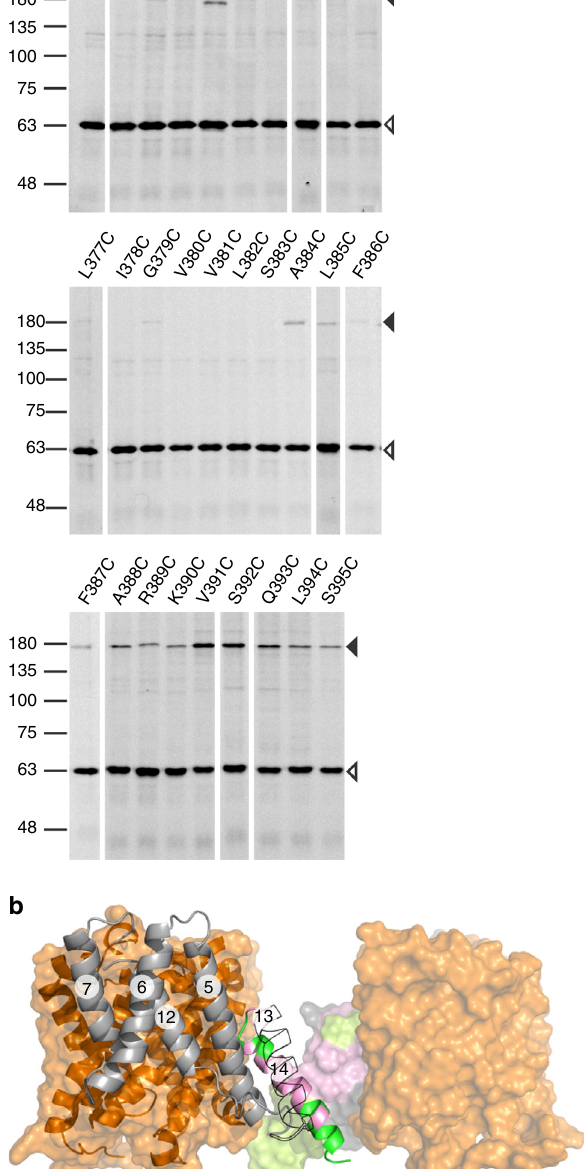
Fig. 4 Oxidative cysteine cross-linking between TM14 of SLC26Dg. a In gel GFP fl uorescence analysis of disrupted E. coli cells expressing single- cysteine variants of SLC26Dg fused to superfolder GFP. Following oxidative cross-linking, samples were analyzed by non-reducing SDS- PAGE. Cysteine-free SLC26Dg (cysless) and L144C (TM5) represent negative controls. Black and white arrows indicate dimeric and monomeric SLC26Dg. Source data are provided as a Source Data fi le. b Side view of the SLC26Dg dimer model. Core and gate domain are colored orange and gray, respectively. Positions in TM14 susceptible to cross-linking are colored in green, non-susceptible residues are colored pink. The gate domain of the right protomer is depicted in surface representation. TM13 of the left protomer is contoured. The circled numbers indicate